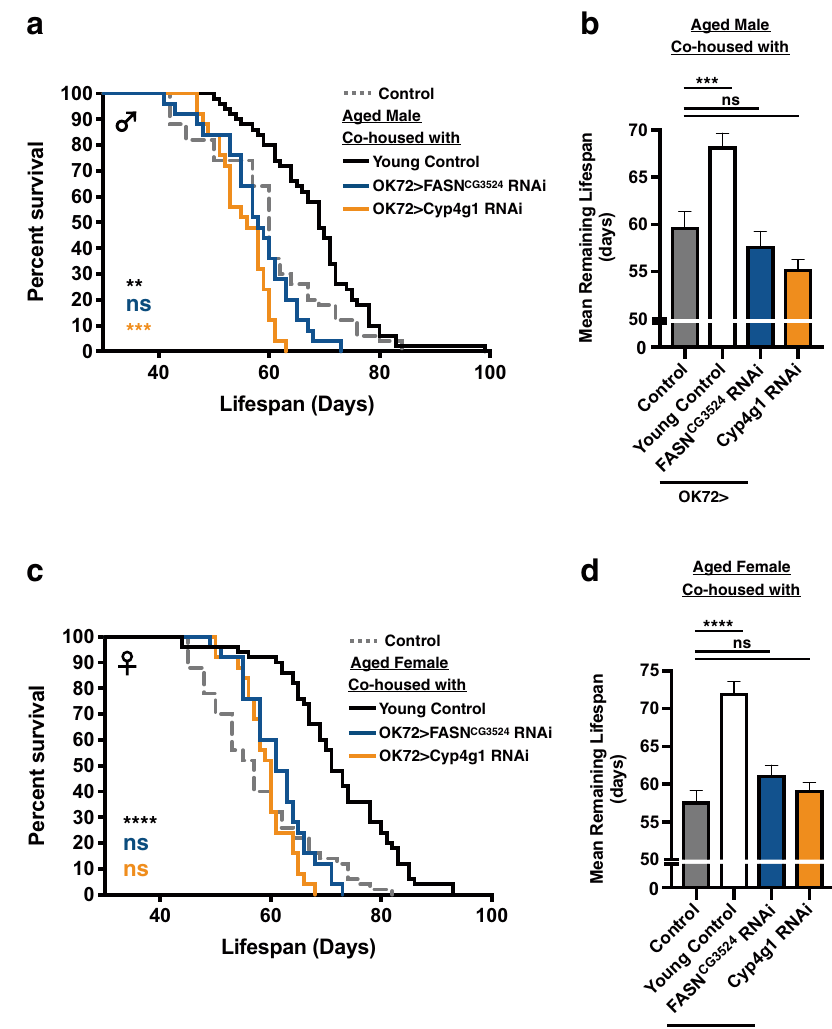
Fig. 6 The pro-longevity capability is diminished in young fl ies defective in generating cuticular hydrocarbons (CHCs). 40d-old aged fl ies were co-housed with 1d-old young control (indicated as Young Control), OK72-GAL4 > UAS-FASN CG3524 RNAi (indicated as OK72 > FASN CG3524 RNAi), and OK72-GAL4 > UAS-Cyp4g1 RNAi (indicated as OK72 > Cyp4g1 RNAi) fl ies at the ratio of 1:3. Survival results of co-housed aged fl ies were expressed as survival curves and means ± SEM. ( a , b ) for male fl ies, and ( c , d ) for female fl ies. P values: ns > 0.1234; < 0.0021**; < 0.0002***; <0.0001****. P values of the columns were annotated by the Kruskal – Wallis test and followed by Dunn ’ s multiple comparison test and survival curves were annotated by the Log-rank (Mantel-Cox) test. Sample size: (1) Control and Young Control, n = 50 from 10 independent experimental sets, (2) OK72 > FASN CG3524 RNAi and OK72 > Cyp4g1 RNAi, n = 25 from 5 independent experimental